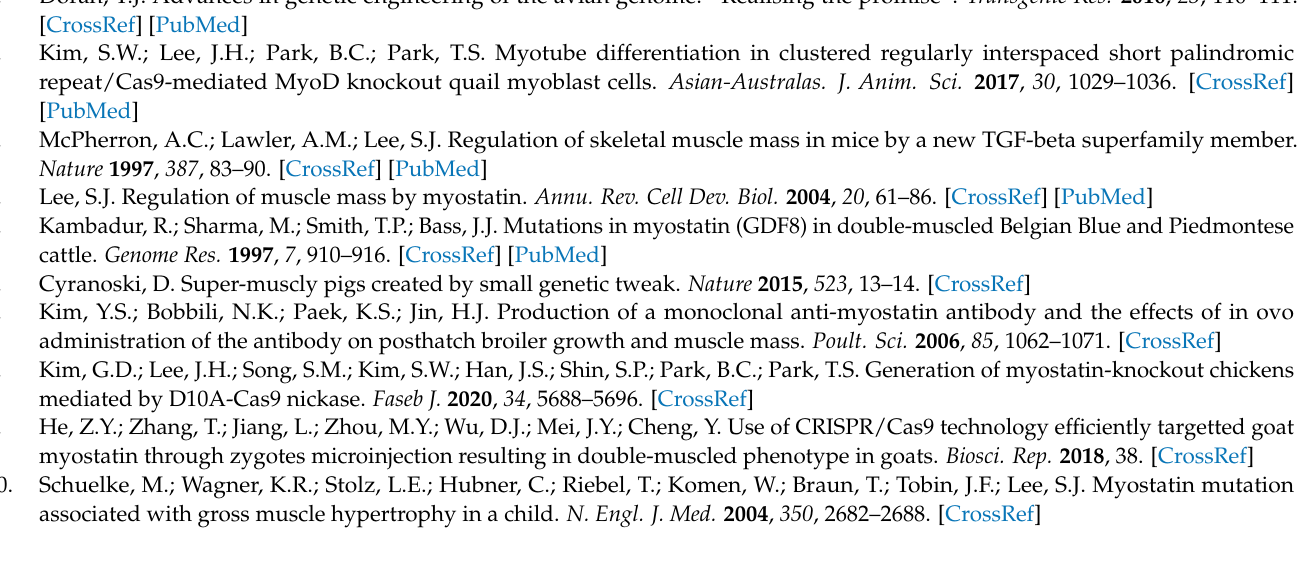
Figure S2: Representative gene ontology (GO) enrichment terms of DEGs in the CFM_KO vs. CFM_WT groups and CEF_KO vs. CEF_WT, Table S1: Prime list, Table S2: The differentially expressed genes in CFM_KO vs. CFM_WT, Table S3: GO enrichment terms of DEGs in the CFM_KO vs. CFM_WT groups, Table S4: KEGG enrichment terms of DEGs in the CFM_KO vs. CFM_WT groups, Table S5: Canonical pathways about cellular growth, proliferation, and development in the CFM_KO vs. CFM_WT, Table S6: The differentially expressed genes in CEF_KO vs. CEF_WT, Table S7: The differential genes that were only expressed in CFM_KO vs. CFM_WT, Table S8: GO enrichment terms of DEGs in the CEF_KO vs. CEF_WT groups, Table S9: KEGG enrichment terms of DEGs in the CEF_KO vs. CEF_WT groups, Table S10: Canonical pathways about cellular growth, proliferation, and development in the CEF_KO vs.